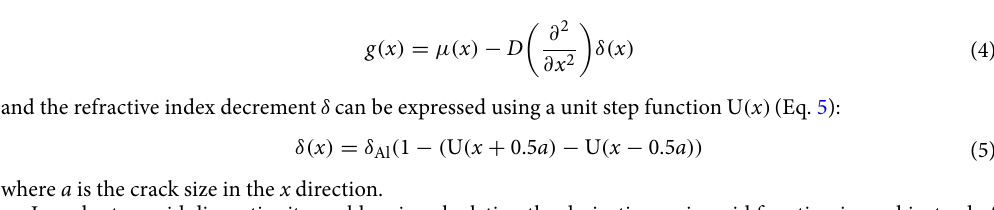
Figure 10. The simplified one-dimensional solution of WTIF model (Eq. 4) is used to discuss the relationship between the crack gray-scale values and the crack size. ( a ) Attenuation coefficient of a one-dimensional crack along the X-axis: the black line is the ideal case (modeled by impulse function), the dashed green line is the 1 simplified case (modeled by a Sigmoid function with w = 100 µ m − ; ( b ) Distribution of g(x) along the x-axis (crack size = 1 µ m); ( c ) Distribution of g(x) along the x-axis (crack size = 5 µ m); ( d ) Normalized contrast (Eq. 1) of crack center for different crack sizes; ( e ) Distribution of g(x) along the x-axis (crack size=10 µ m); ( f ) Distribution of g(x) along the x-axis (crack size=100 µ